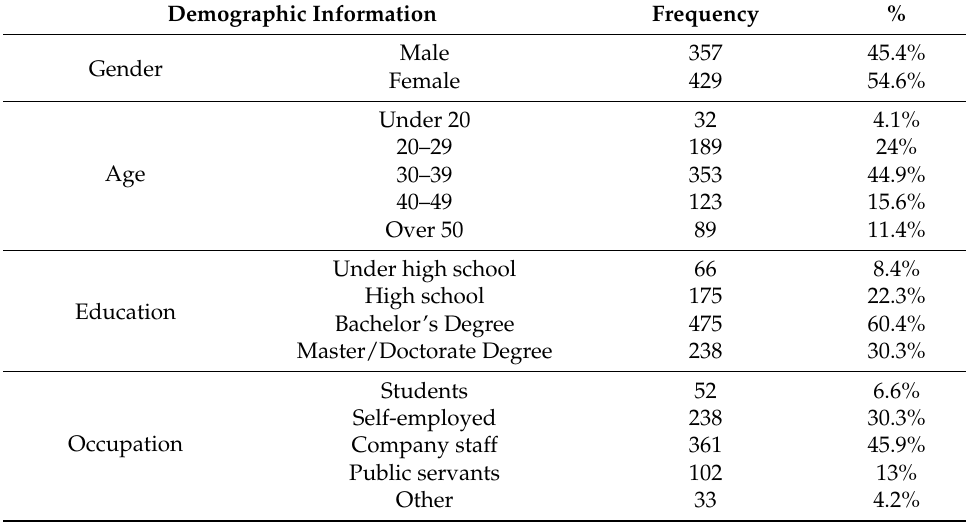
Table 2. Demographic